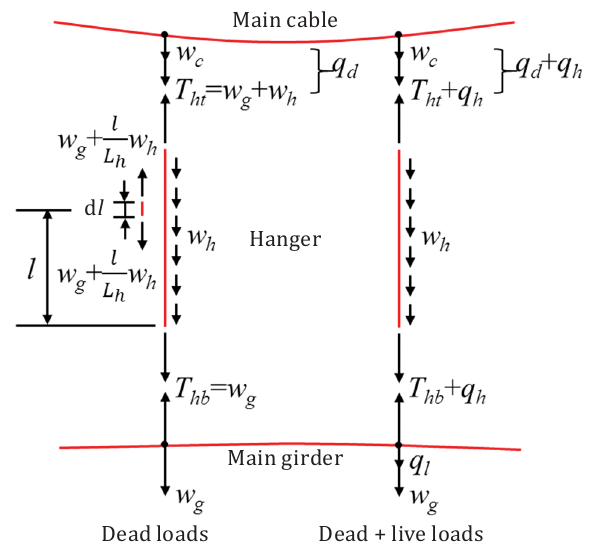
Figure 2. Free body diagrams of main cable, main girder and